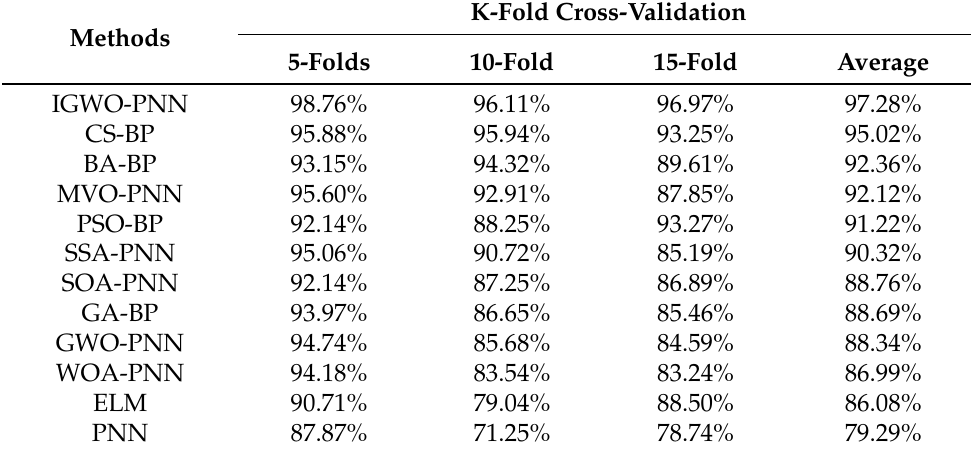
Table 9. K-fold cross-validation results of different